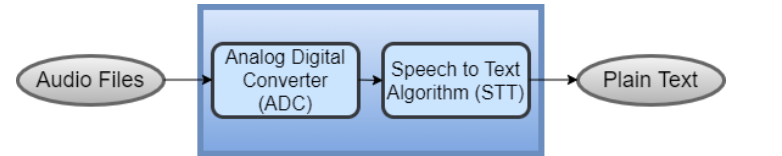
Figure 6. Audio to Plaintext Transcription Process.